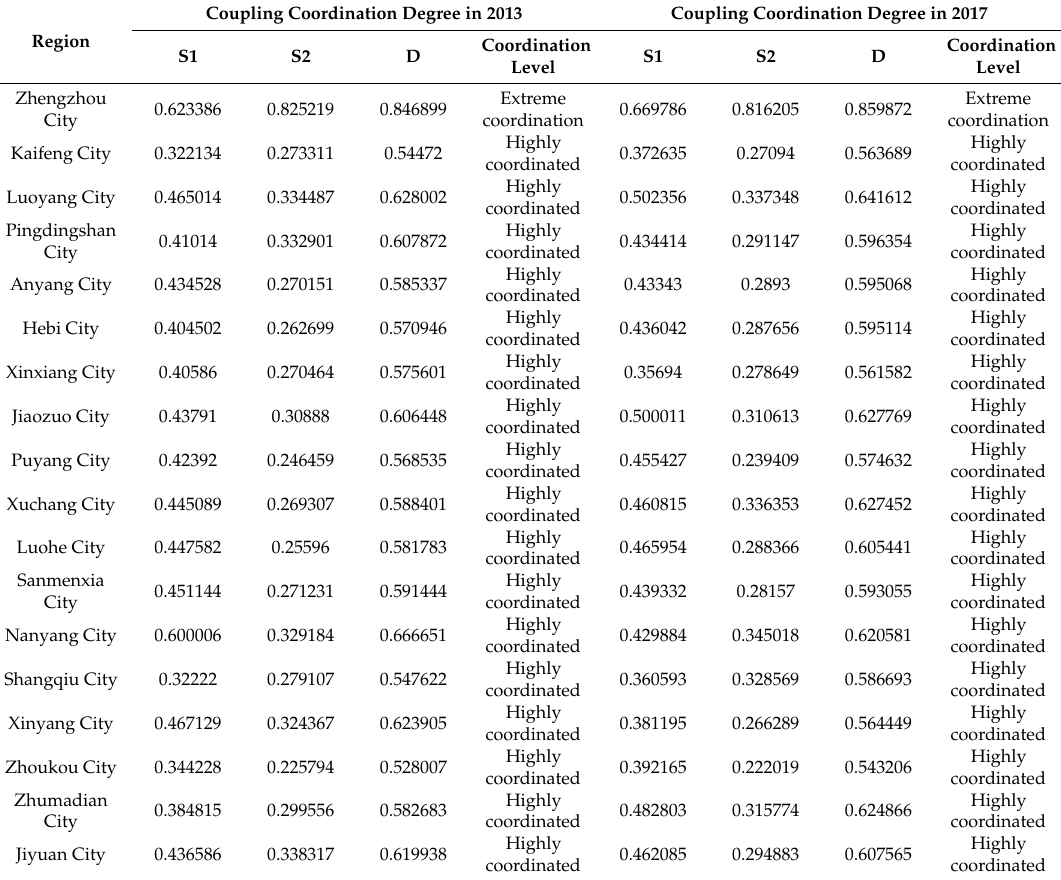
Table 3. Calculation results of the coupling degree of regional infrastructure construction and economic